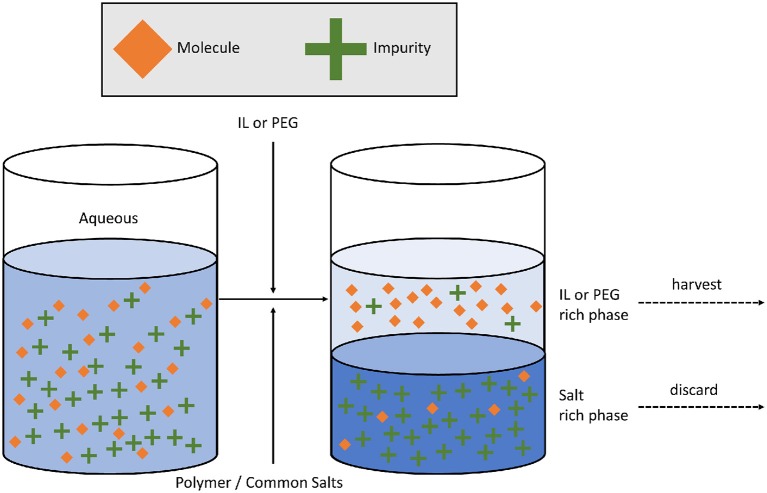
The use of polymer-based or IL-based ATPSs for separations critically depends on selective partitioning of the molecule over impurities. Impeller agitation is often employed to speed up equilibrium partitioning. Depending on viscosity and density differences and interfacial tension values, physical separation can be as simple as sedimentation or as complex as industrial centrifugation to isolate the liquid phase containing the molecule of interest.